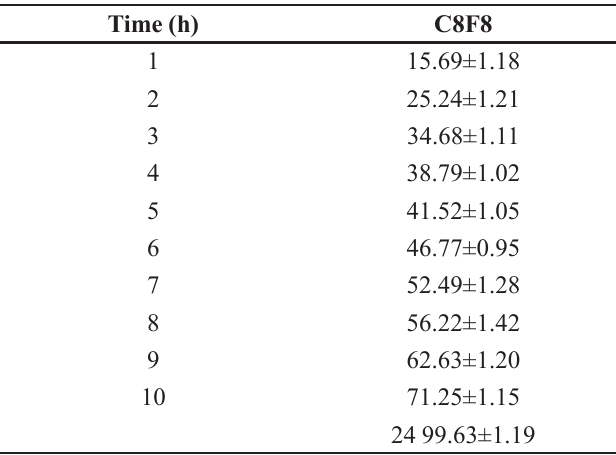
TABLE VIII - Dissolution data of ofloxacin in bilayer tablets